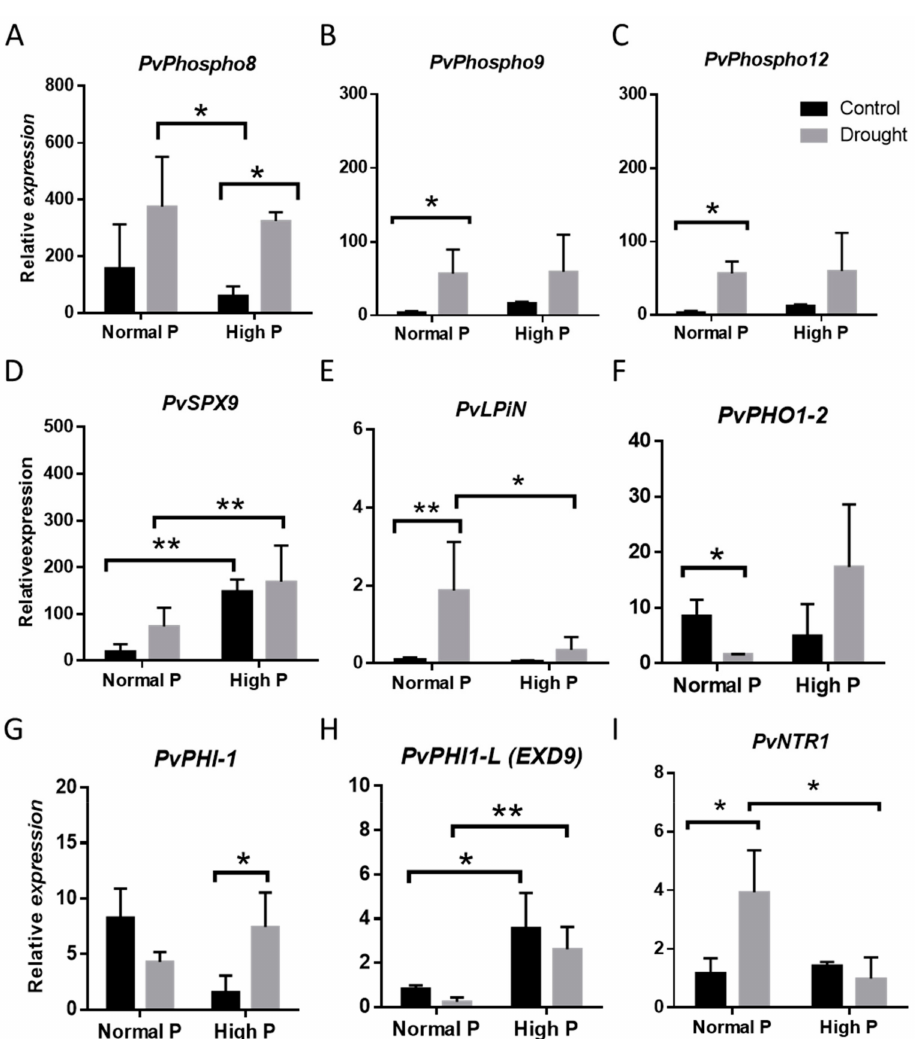
Figure 4. The relative expression of phosphate starvation-related stress genes in leaves from control and 10 days-drought-stressed plants that were grown under symbiotic nitrogen fixation conditions with 82 µ M of KH 2 PO 4 (Normal P) or received 200 µ M of KH 2 PO 4 (High P) for one week, just before the drought treatment. ( A – C ) Relative expression of PvPhospho8, PvPhospho9, PvPhospho12 ; ( D ) PvSPX9; ( E ) PvLPIN; ( F ) PvPHO1-2; (G) PvPHI-1 ; ( H ) PvPHI1-L or EXORDEUM 9 ; ( I ) PvNTR1 expression in response to P supplementation and drought. Data are means of three independent experiments. Asterisks indicate statistically di ff erences (* p < 0.05 ) and (** p <